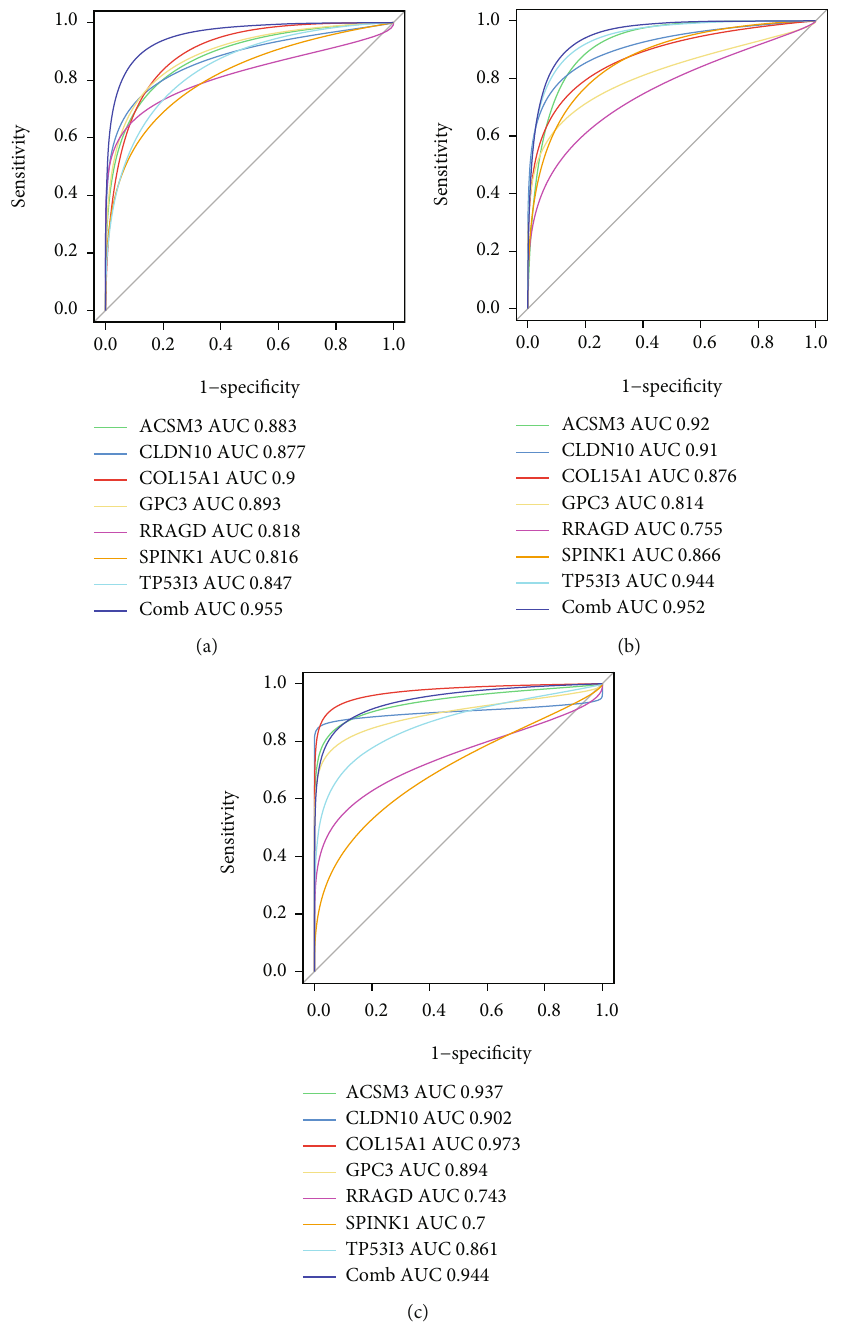
Figure 6: The ROC curve of the discrimination ability of the seven identi fi ed diagnostic gene biomarkers for early-stage HCC in cohorts. (a) GSE14520-GPL3921 cohort. (b) ICGC-LIRI-JP cohort. (c) The TCGA